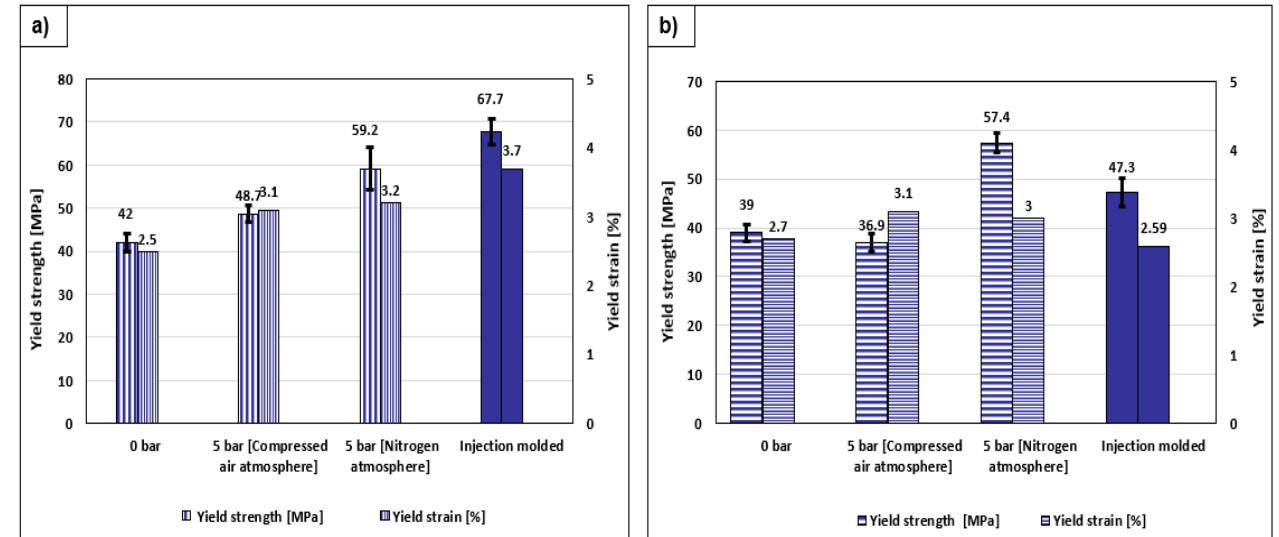
Figure 5. Comparison of the yield strength and yield strain of samples printed at various pressure settings longitudinally ( a ) and transversely ( b ).